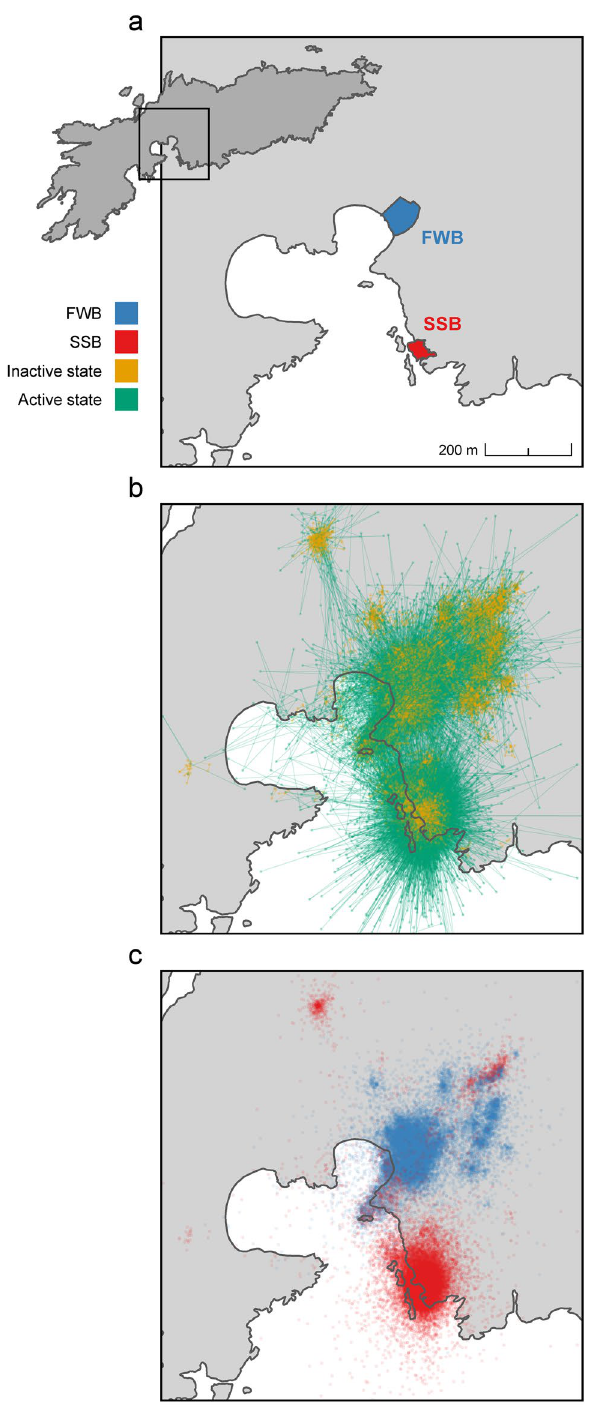
Figure 2. Movement patterns of Antarctic fur seal pups on Bird Island, South Georgia. ( a ) Location of the two fur seal breeding colonies, Freshwater Beach (FWB) and the Special Study Beach (SSB), from which pups were tagged with GPS loggers. ( b ) Decoded states from the HMM showing the inferred activity patterns of 66 pups throughout ontogeny. ( c ) GPS locations recorded throughout ontogeny for 32 pups born on FWB and 34 pups born on SSB. To aid visibility, each panel is a magnified view of Bird Island (longitude range = − 38.060 − 38.045, latitude range = − 54.014 − 54.005) and consequently, a small proportion of decoded states and GPS points recorded outside this frame are not